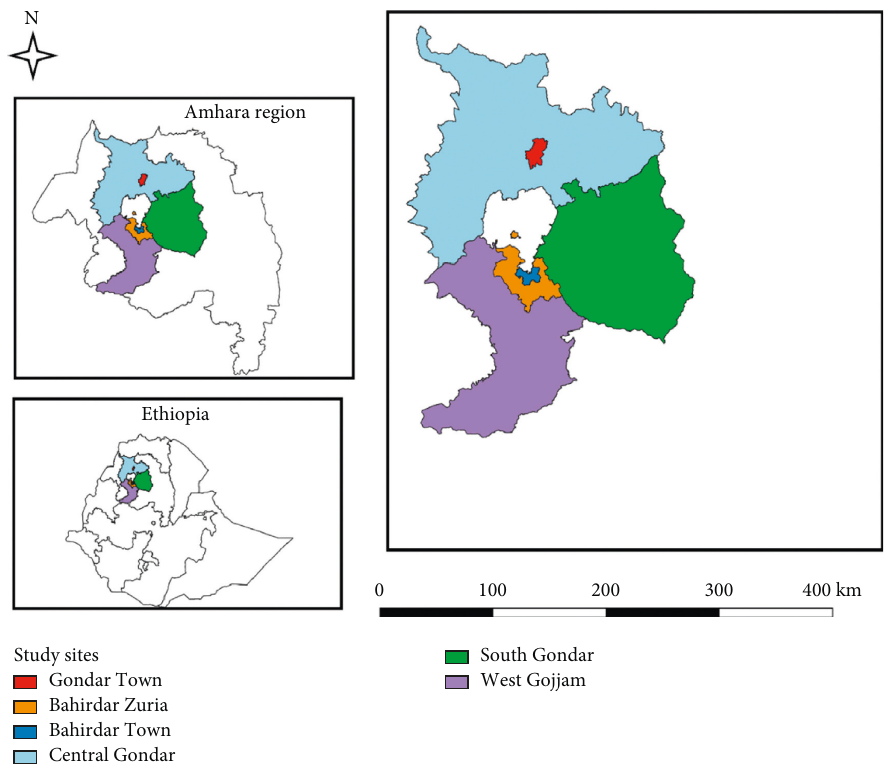
Figure 1: Map showing the study area (created using QGIS